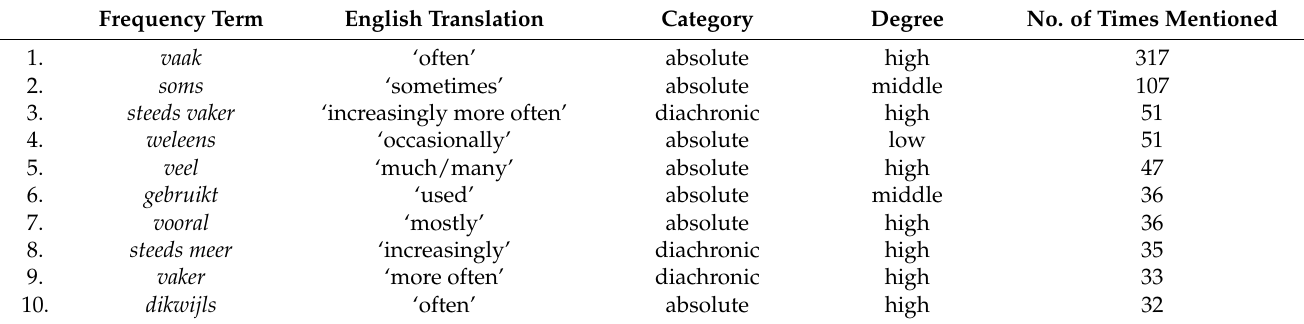
Table 5. Top-10 most frequently used frequency terms.